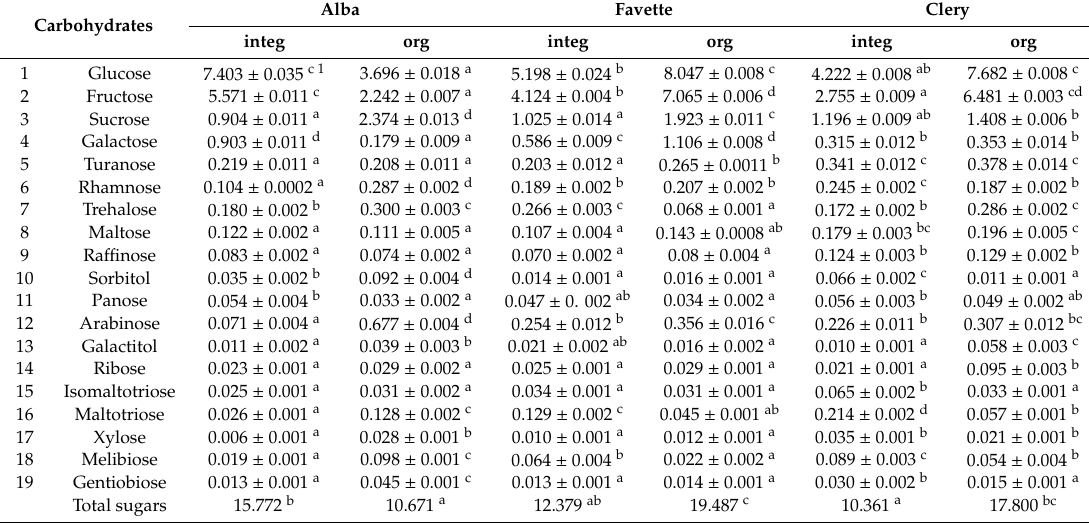
Table 3. Average contents of carbohydrates (mg / g) in integrated (integ) and organic (org) strawberry leaves from three replications.